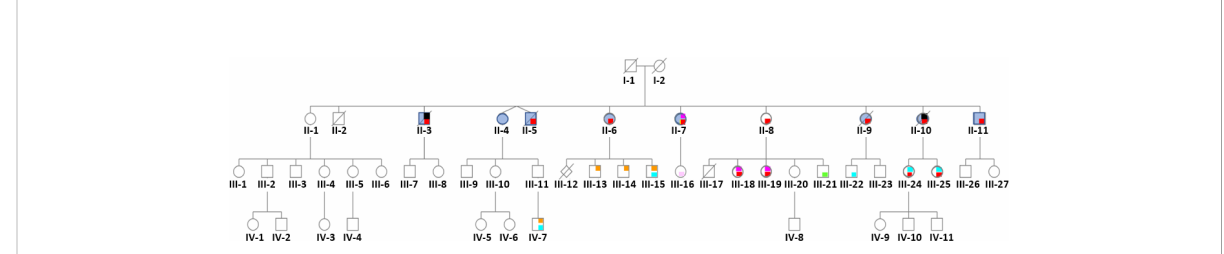
FIGURE 2 Pedigree of an informative family where the mother (I-2) was treated with DES (30 mg/day) for 3 months after each delivery to inhibit lactation. Only the fi rst child (II-1) was not exposed to DES in utero . Daughter II-1 and her descendants do not have any psychiatric disorder. No history of psychiatric disorders was reported for the maternal and paternal sides. red = bipolar disorder, yellow = psychosis borderline, blue = attempted suicide(s), black = suicide, orange = autism spectrum disorder, light blue = dyspraxia and learning disabilities, light pink = mood and sleep disorders, green = behavioral disorders, fuchsia = eating disorders. © Soyer-Gobillard et al. (42) IJERPH, 18, 9965,